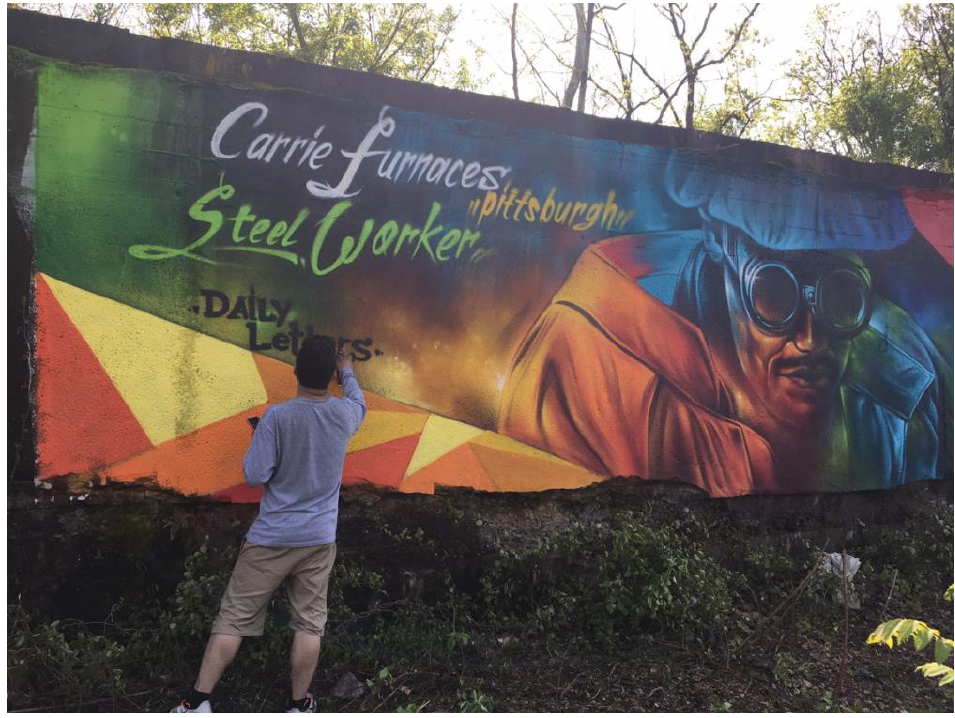
Caitlin Frances Bruce, Orion, Steel Worker, Aerosol paint on wall, 2017, Rankin, Pennsylvania. Copyright: Caitlin Frances Bruce.